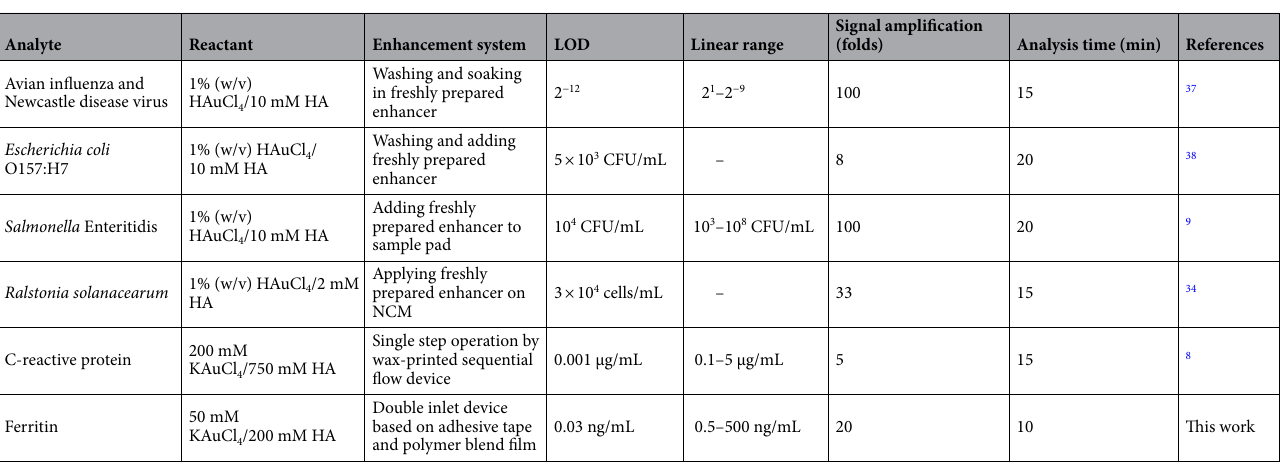
Table 1. Comparison of the signal amplification of AuNP-based LFIAs using a gold